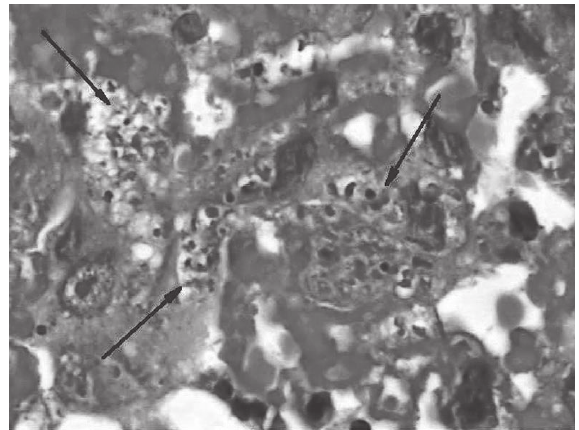
Fig. 2 - Células histiocitárias com citoplasmas multivacuolizados e corpúsculos intravacuolares (H&E -